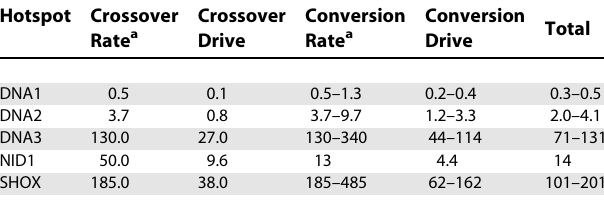
Table 1. Estimated Magnitude of Drive Parameters Corre- sponding to an Example Set of Human Hotspots, Based on N e ¼